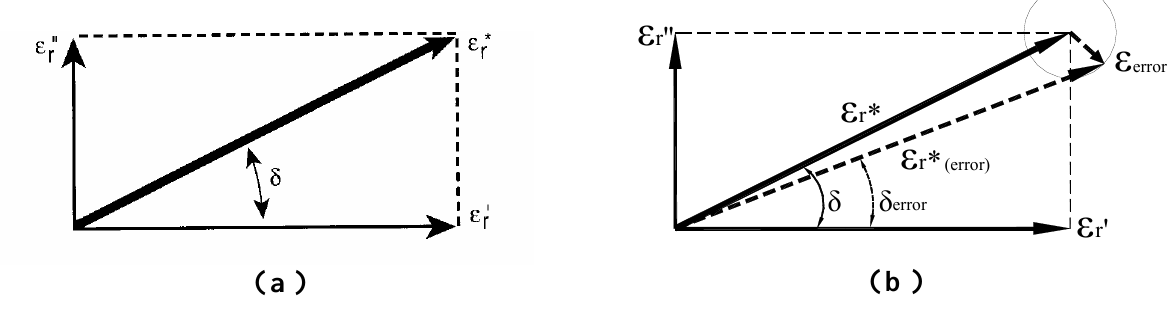
Figure 2. The complex relative permittivity vector diagram. (a) The angle δ definition according to eq.5. (b) During permittivity measurements an error vector ( ε ), related to the experimental set-up, error is always added to the relative complex permittivity vector. This vector becomes significant only for highly insulating materials, because ⏐ε ′′⏐→ 0 and becomes comparable to ⏐ε ⏐ r error